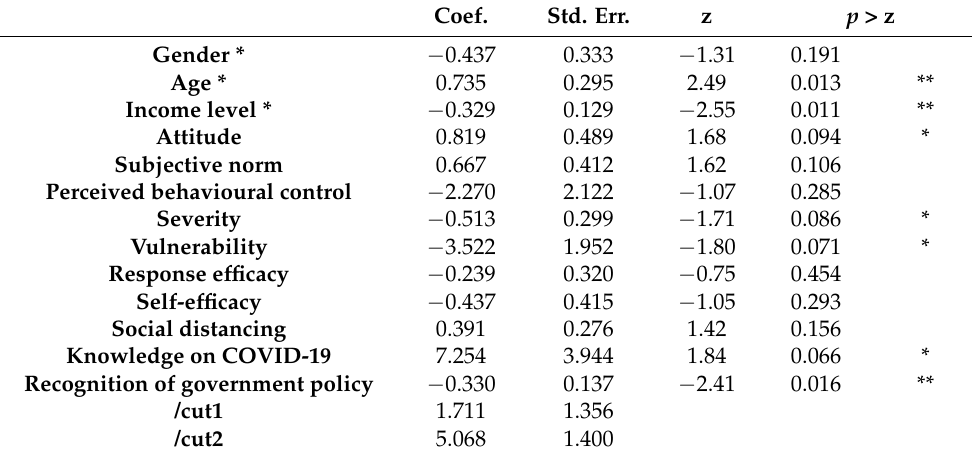
Table 5. Determinants leading to selection of offline shopping channels after stabilization of COVID-19. Coef. Std. Err. z p >